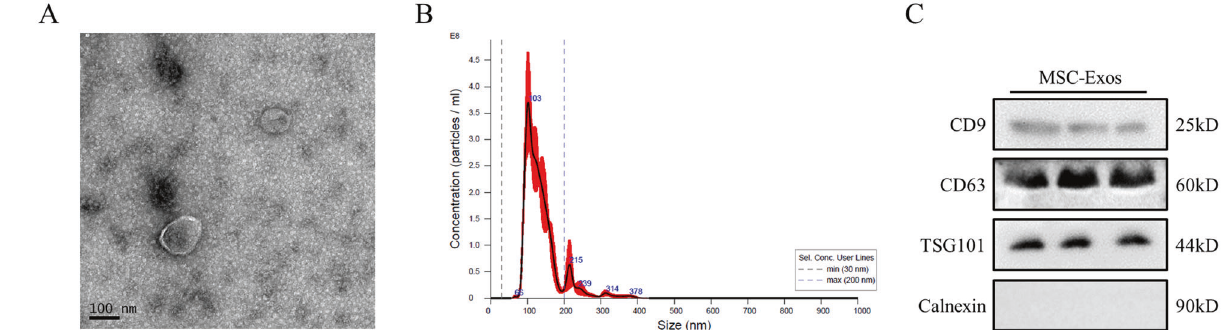
Fig. 1 Isolation and identi fi cation of MSC-Exos. A The morphology of MSC-Exos was observed by TEM (scale bar = 100 nm). Representative images from one experiment out of three are shown. B Representative results of NTA of MSC-Exos from three independent experiments. C Western blot analysis of exosomal protein markers (CD9, CD63 and TSG101) and an endoplasmic reticulum marker (calnexin) in